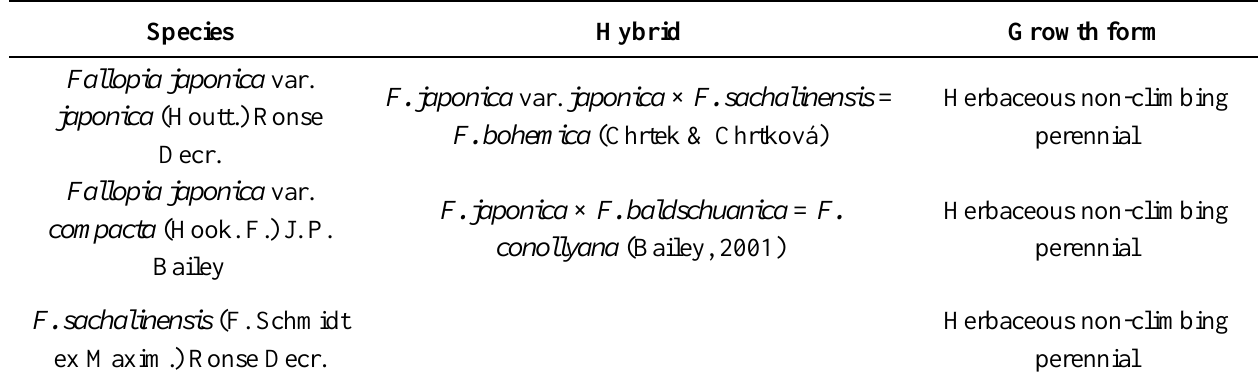
Table 1. Herbaceous non-climbing perennial members of the genus Fallopia considered in the current paper